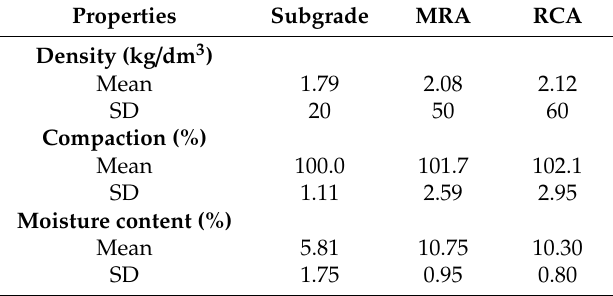
Table 7. In situ assessments of density and